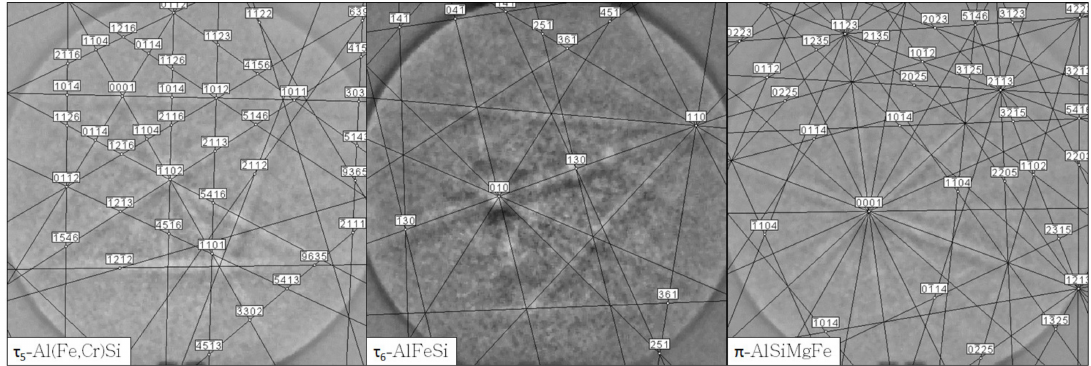
Figure 19. EBSD patterns of τ 5 -Al(Fe,Cr)Si and τ 6 -AlFeSi phases detected in the aluminum alloy of the C_1000